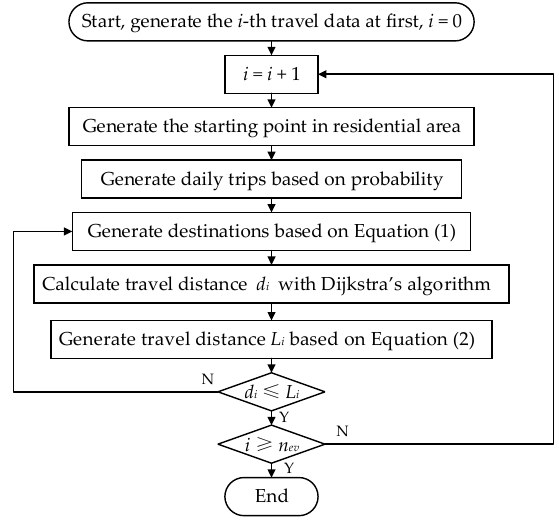
Figure 4. The flowchart of the travel pattern model.